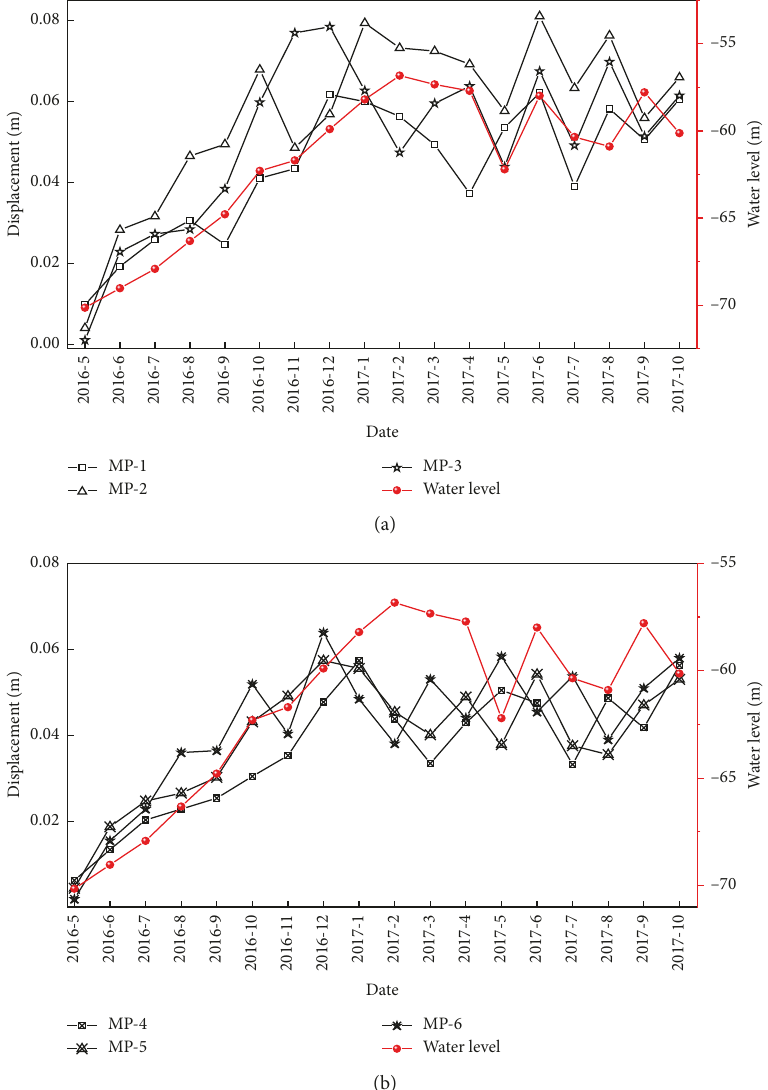
Figure 10: Relationship between slope displacement and water level change. (a) Monitoring points 1, 2, and 3. (b) Monitoring points 4, 5, and